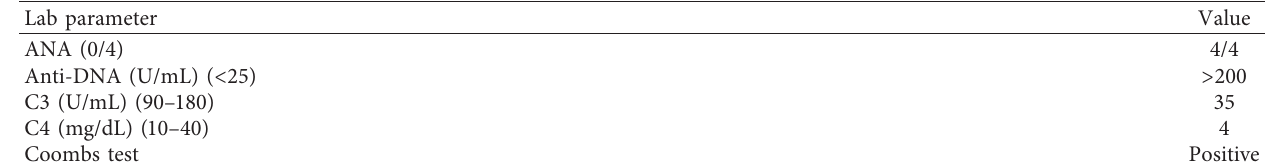
Table 2: The patient’s immune serologies, completed during his